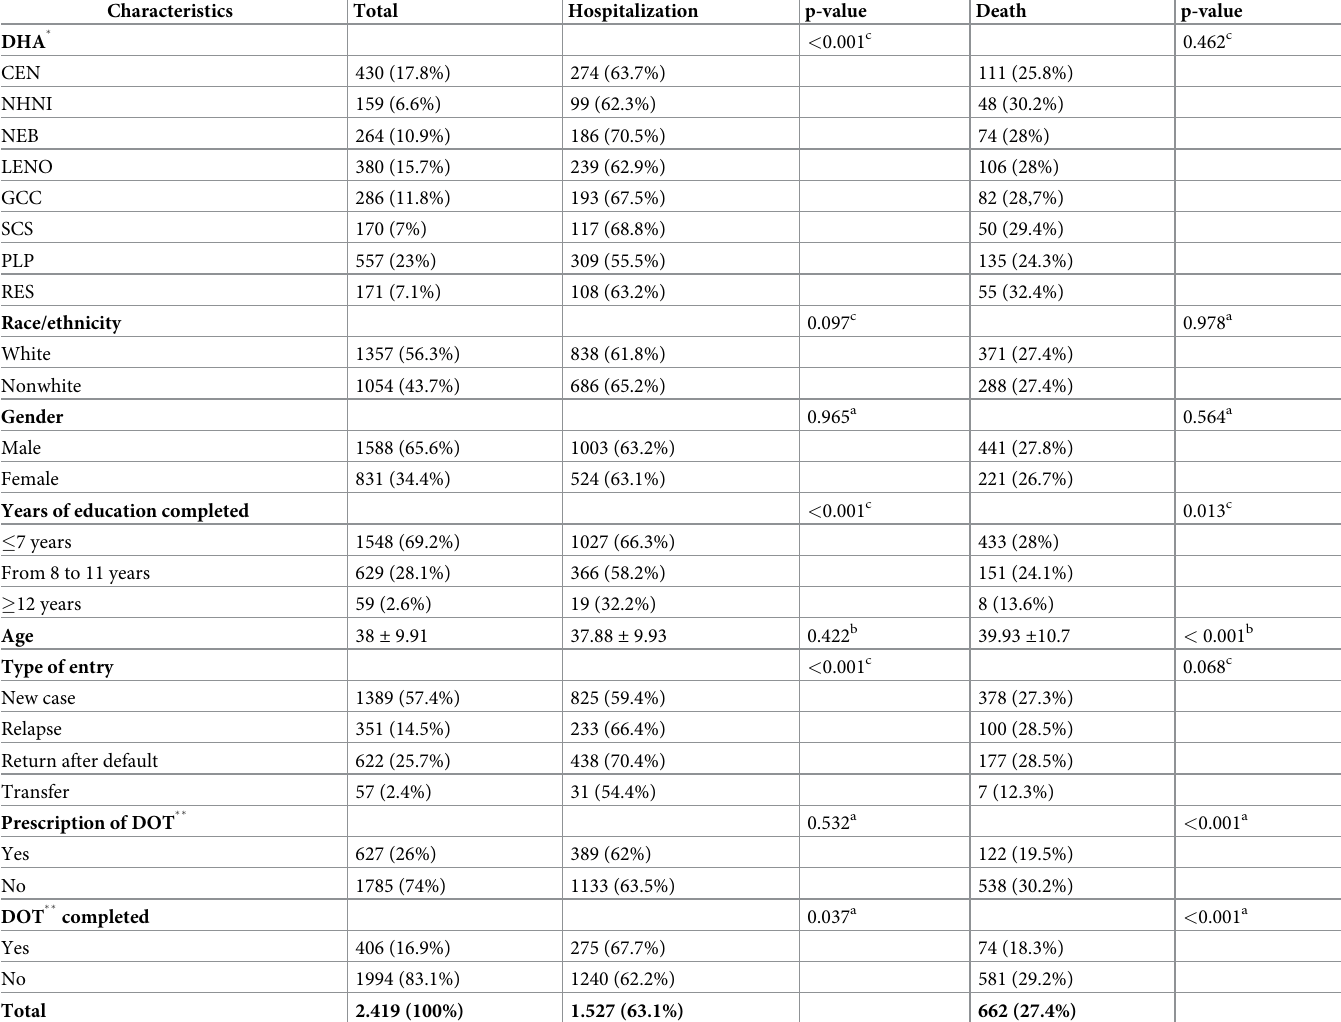
Table 1. Socio-demographic, epidemiological and clinical characteristics of TB/HIV co-infected persons according to the occurrence of hospitalization and death in Porto Alegre, Brazil, from 2009 to 2013.